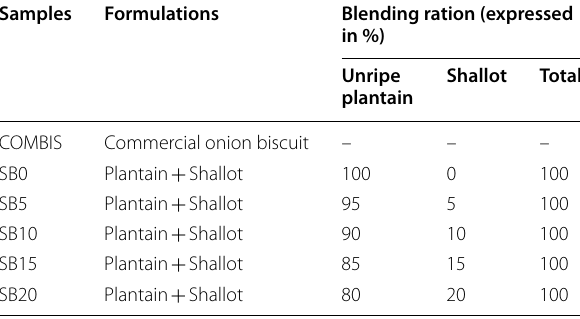
Table 1 Blending ration of plantain-shallot